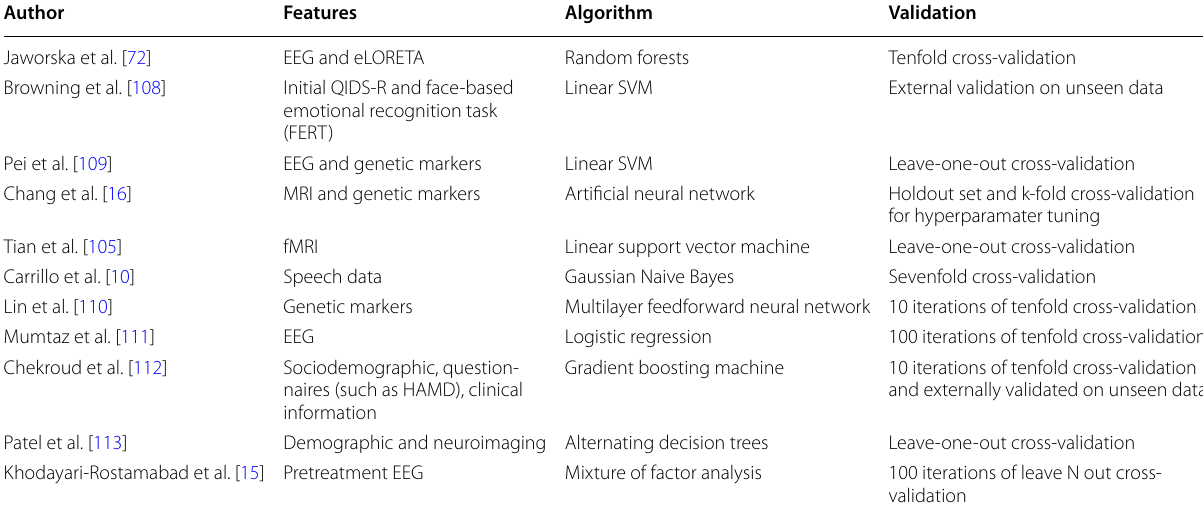
Table 5 Pharmacological treatment response prediction